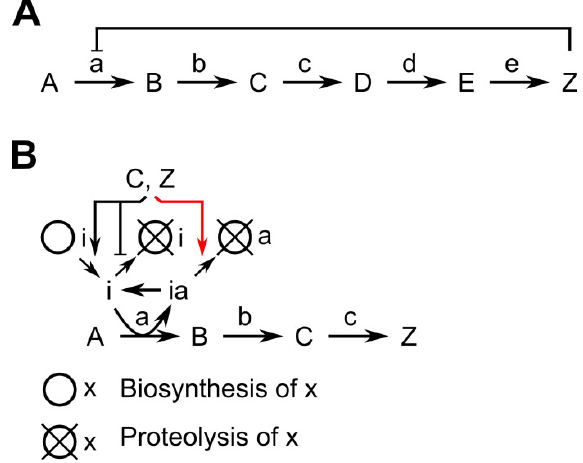
FIGURE 1: Feedback inhibition of enzymes. (A) Classical regula- tion: An end-product (Z) of a biosynthesis pathway inhibits activi- ty of an enzyme (a) catalyzing the first irreversible step (com- mitment step). (B) The polyamines spermidine (C) and spermine (Z) regulate the activity of ornithine decarboxylase (ODC; a) by inducing the biosynthesis of the ODC-inhibitor antizyme (i) and preventing its degradation. Binding of antizyme to ODC (symbol- ized by ia) inhibits ODC activity and induces its degradation; a novel finding is that polyamines directly promote antizyme- mediated degradation of ODC (highlighted by red